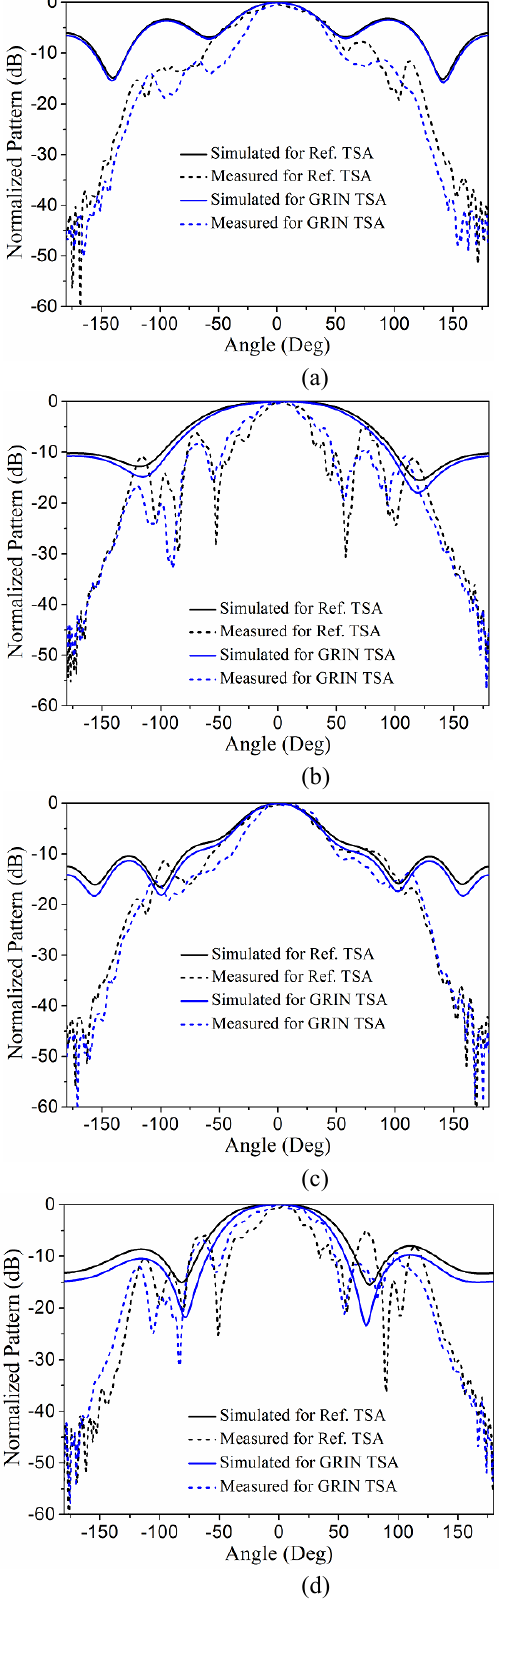
Figure 11: Measured radiation patterns of the reference